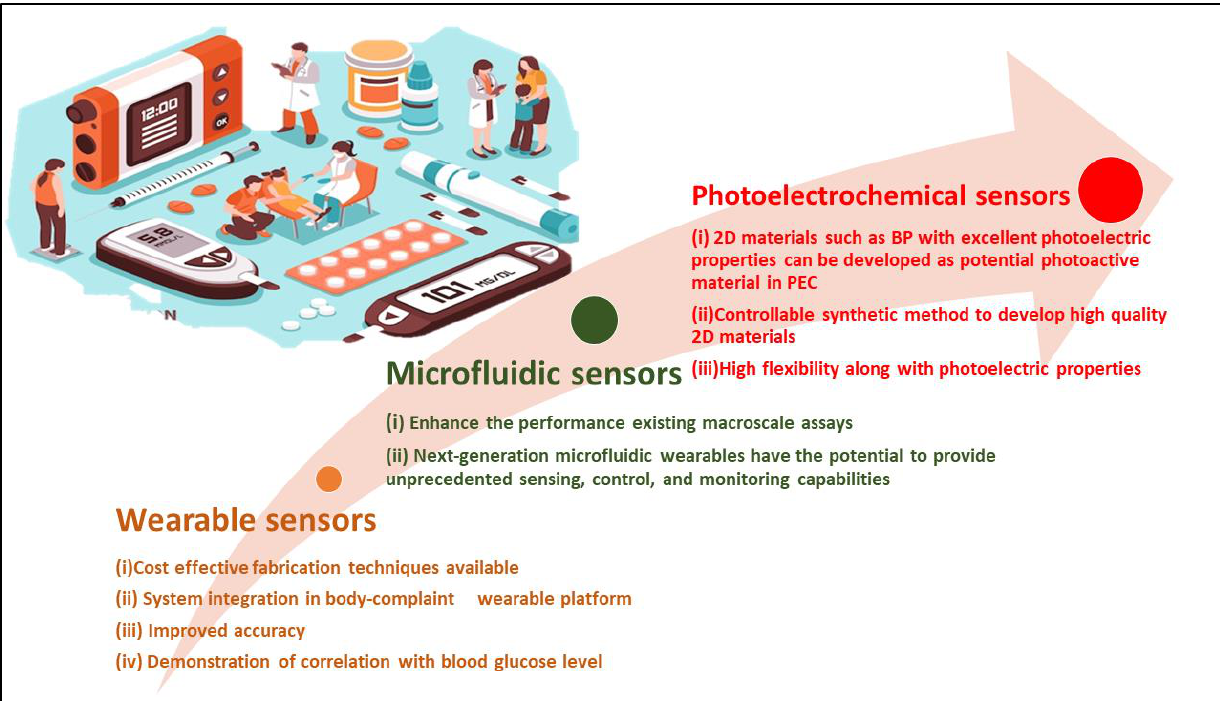
Figure 16. Future prospects on electrochemical glucose sensors based on 2D material.